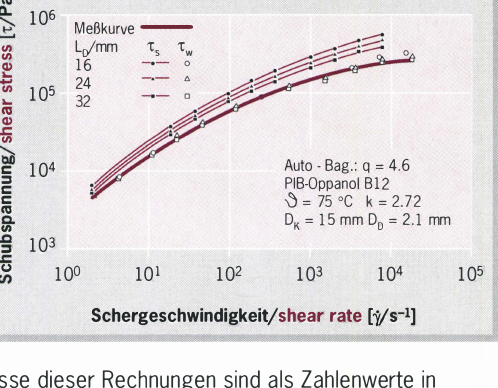
Fig. 10: Apparent melt index viscosity llMVI. corrected melt index viscosity 11 cor and true viscosity llW of LOPE Melt